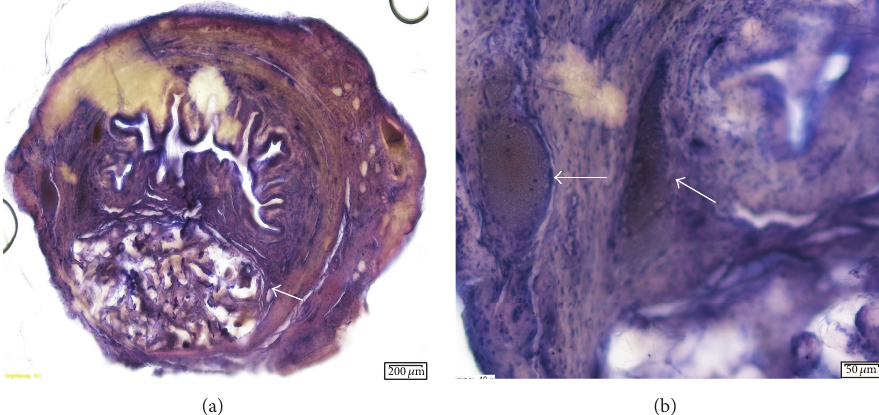
Figure 6: Cross-sections of urethra 5 months after injection of Macroplastique. (a) Cross-section of entire urethra (10x magnification). Arrows indicate bulking material mass in the adventitia and suburothelium. (b) Injected bulking material with some surrounding fibroblastic proliferation (20x